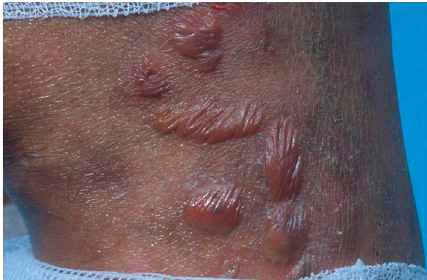
Figure 5: Type 2 reaction: lesions with erythema multiform-like bullous (photograph courtesy of Alemu Belachew, et al.)